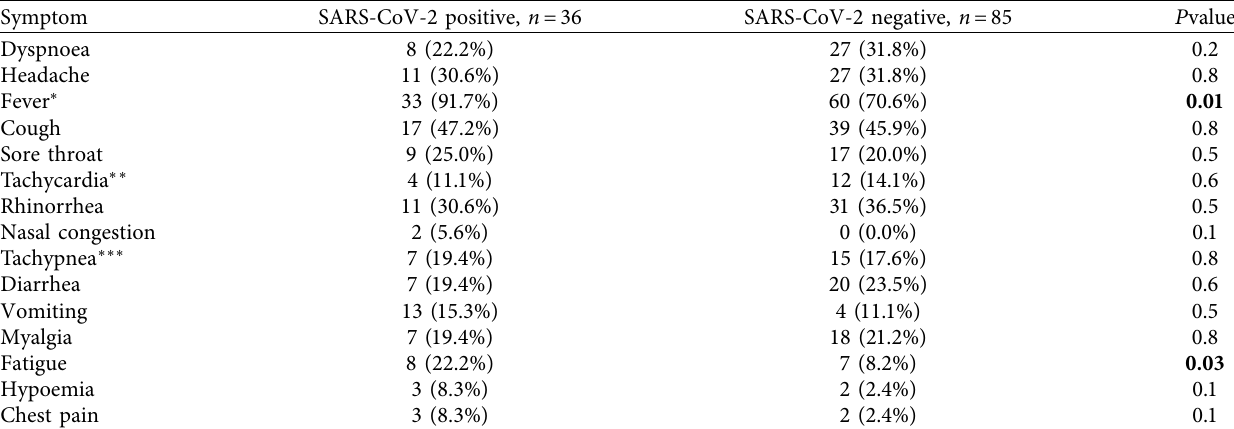
Table 2: Comparison of symptoms between SARS-CoV-2 positive and negative pediatric patients.